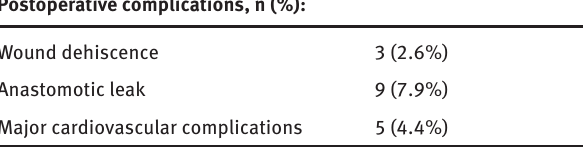
Table 2: Postoperative complication in 17